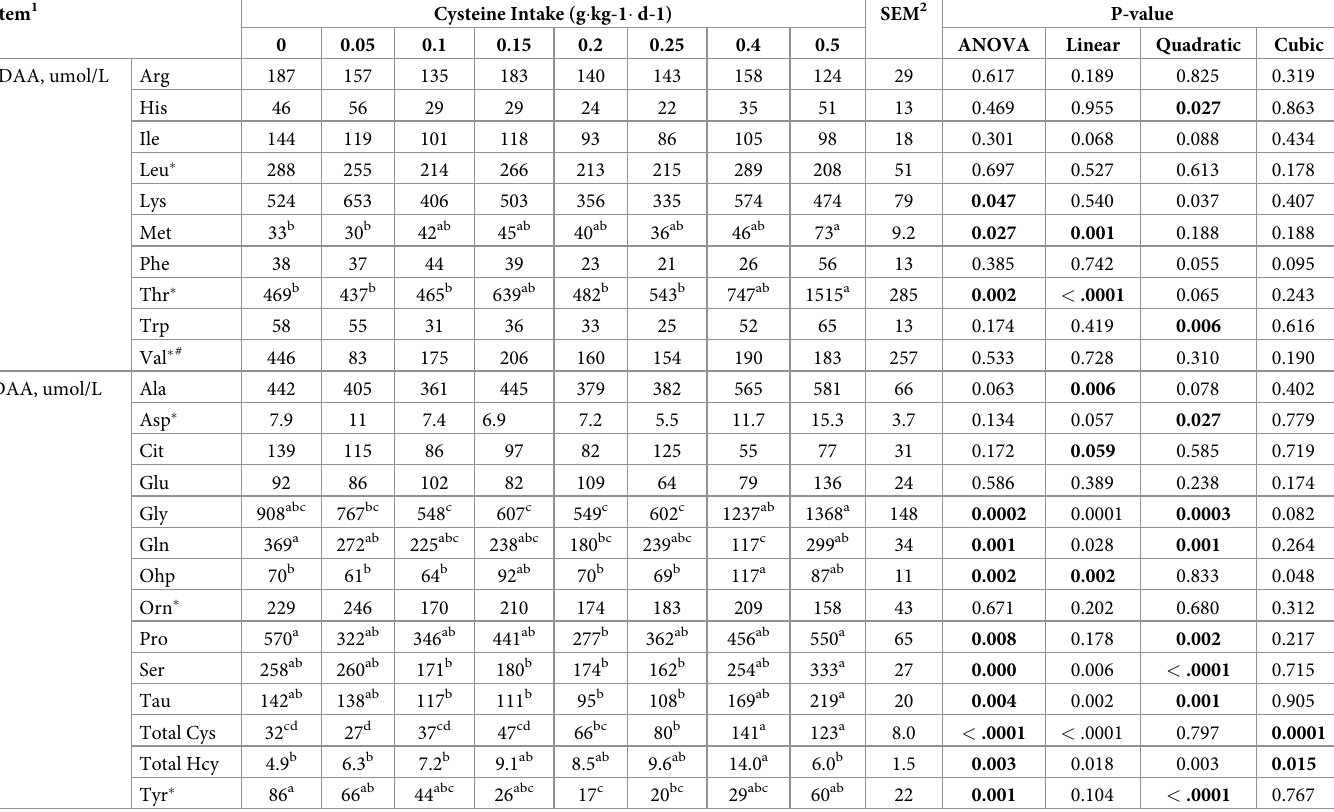
Table 2. Plasma amino acid concentrations in piglets receiving total enteral nutrition after L-[1- 14 C]Met infusion. Item 1